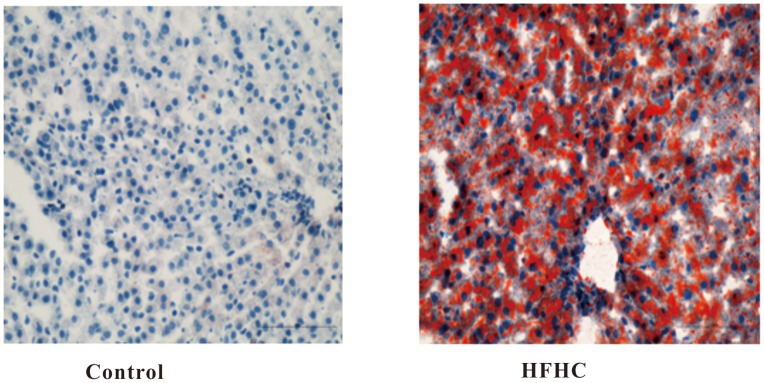
Oil Red O staining of liver tissue from control (left) and HFHC hamsters (right) at week 42 revealed the accumulation of fat in the latter group.